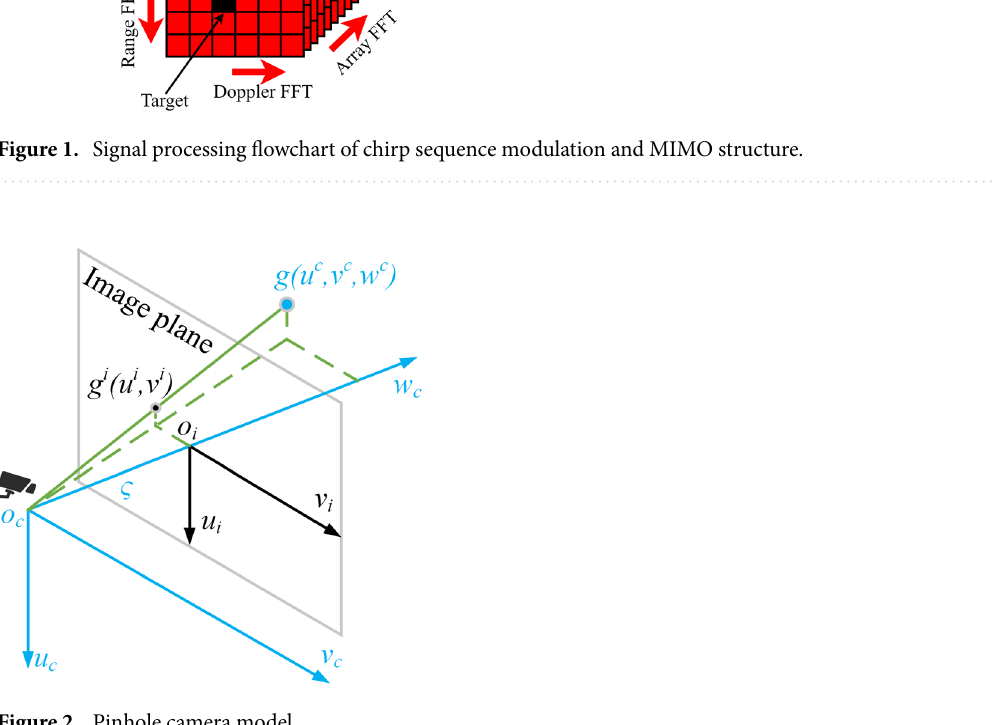
Figure 2. Pinhole camera